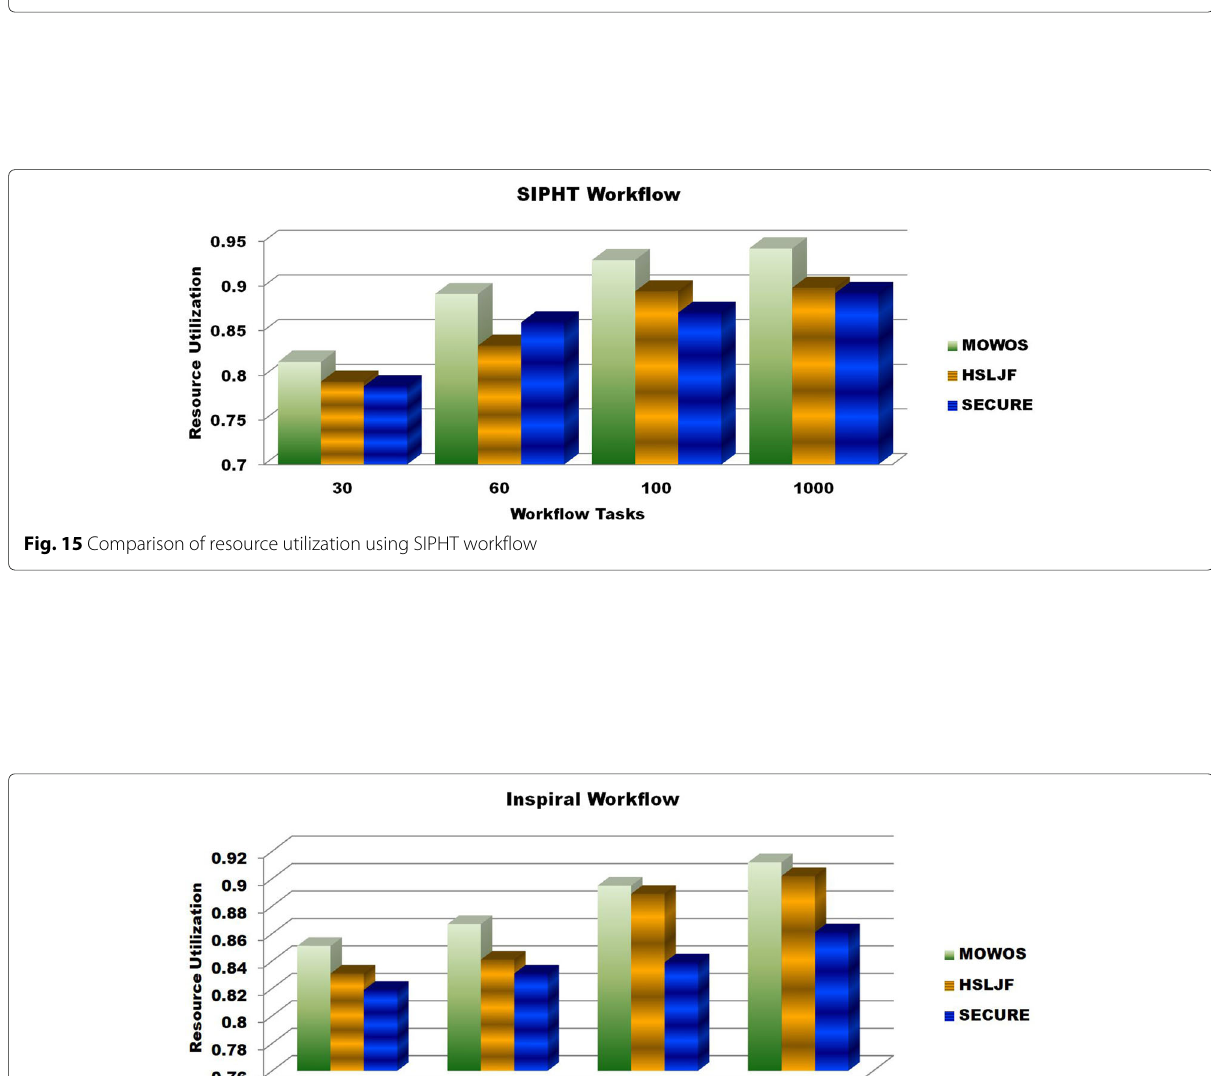
Fig. 14 Comparison of Resource Utilization using CyberShake workflow